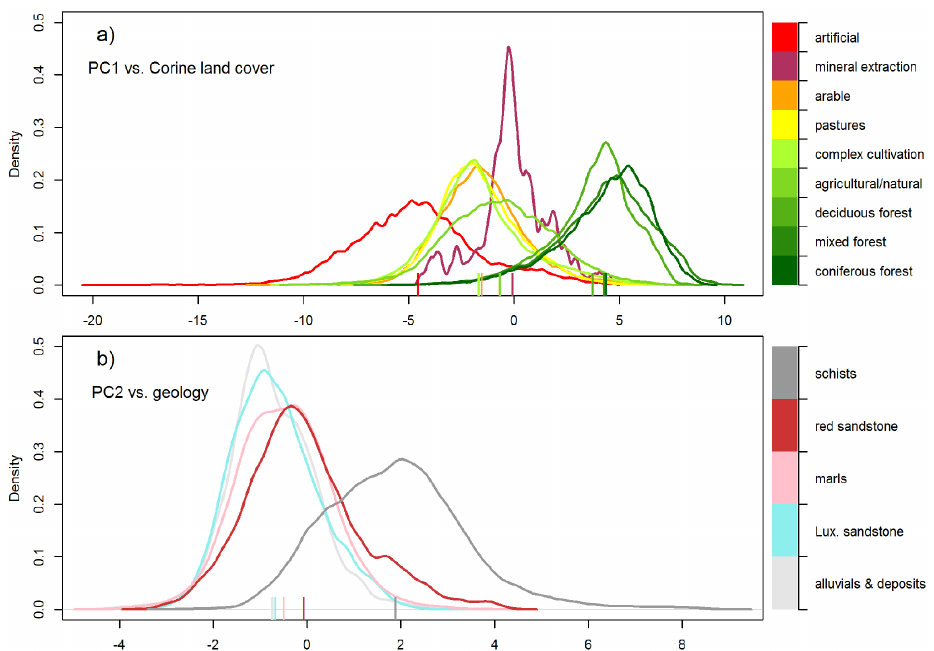
Figure 10. Comparison of component values and spatial information for the Attert catchment. The density distribution of the component values (PC1 in (a) ; PC2 in (b) ) are shown for the different classes of the spatial data sets (Corine land cover in (a) ; geology in (b) ). Mean values of the distributions are shown as vertical bars on the bottom